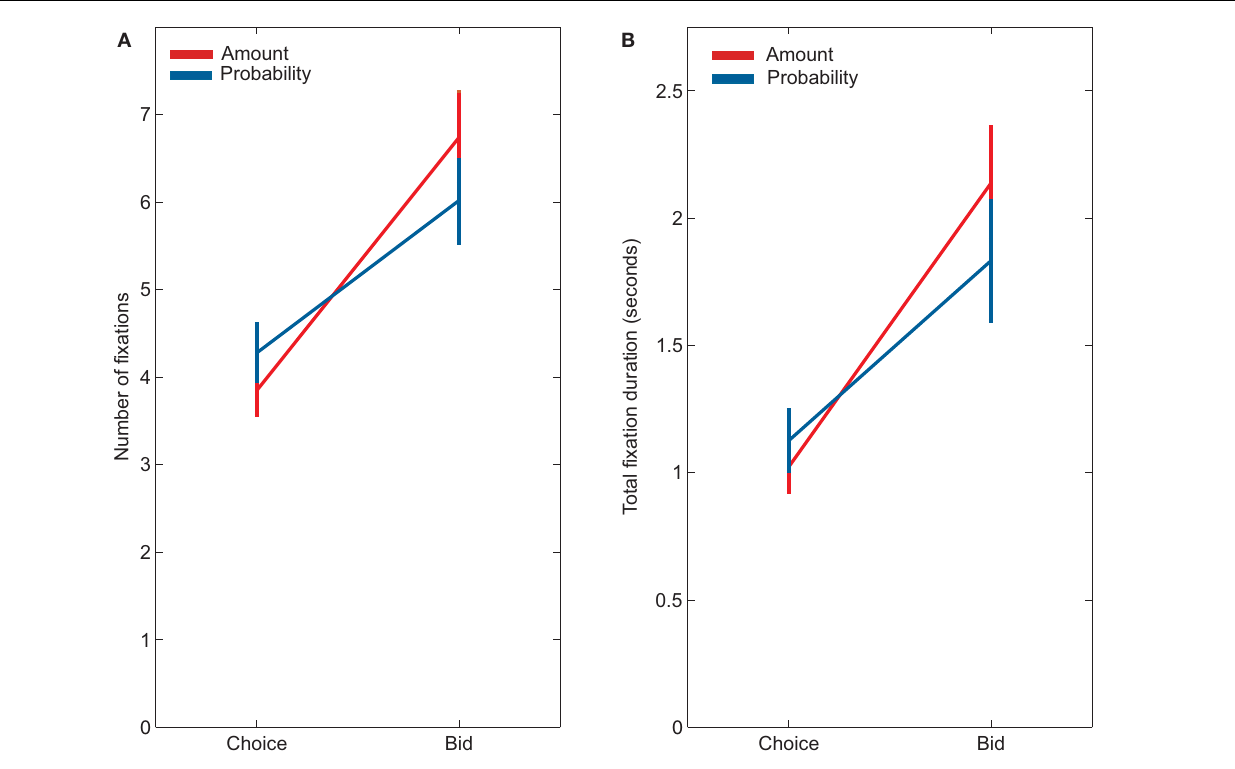
FIGURE 4 | (A) Average number of fixations of probabilities and amounts during choices and bids. (B) Average duration looking at probabilities and amounts during choices and bids.